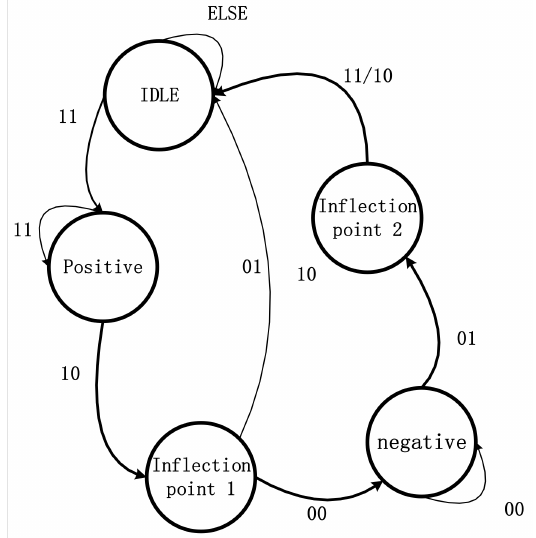
Figure 10. Schematic diagram of state